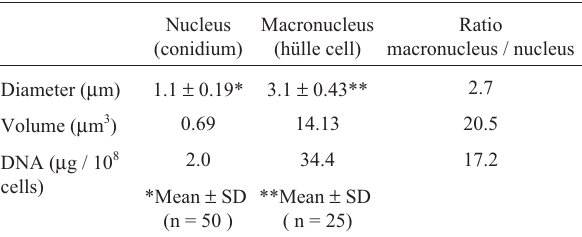
TableI -Comparisonsbetweennucleiofconidiaandmacronucleiofhülle cells.